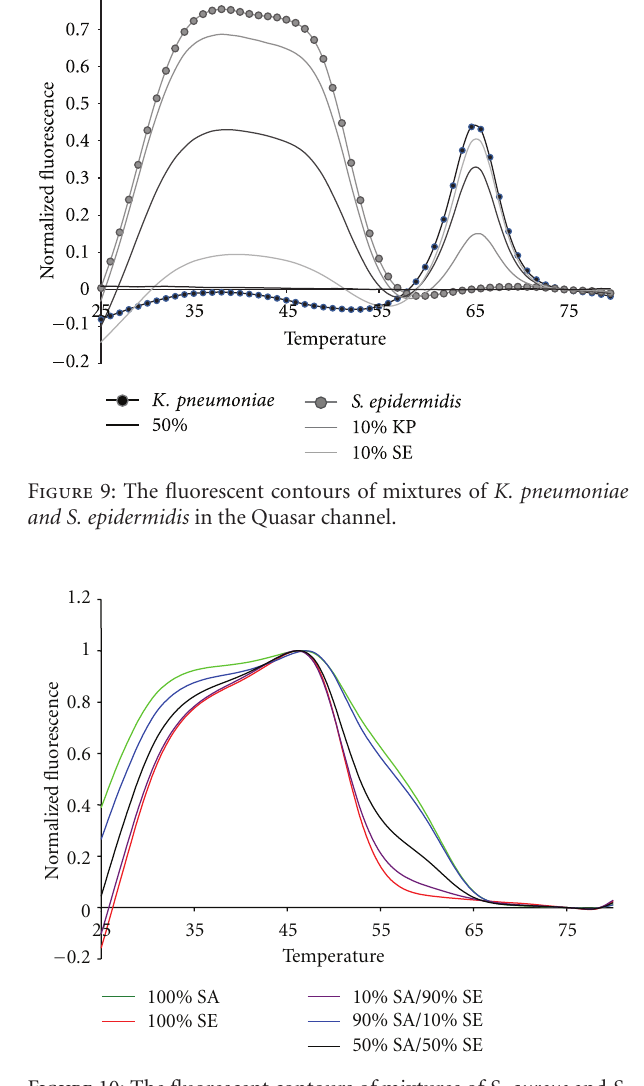
Figure 10: The fluorescent contours of mixtures of S. aureus and S. epidermidis in the Quasar